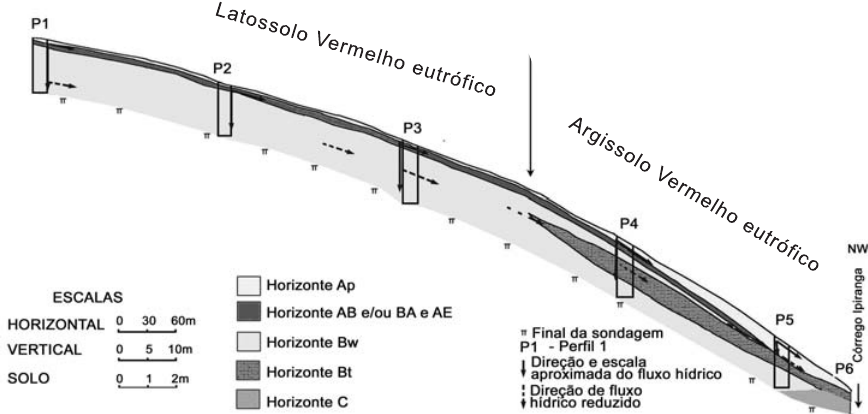
Figura 1. Toposseqüência de solos Campus do Arenito com a indicação dos fluxos